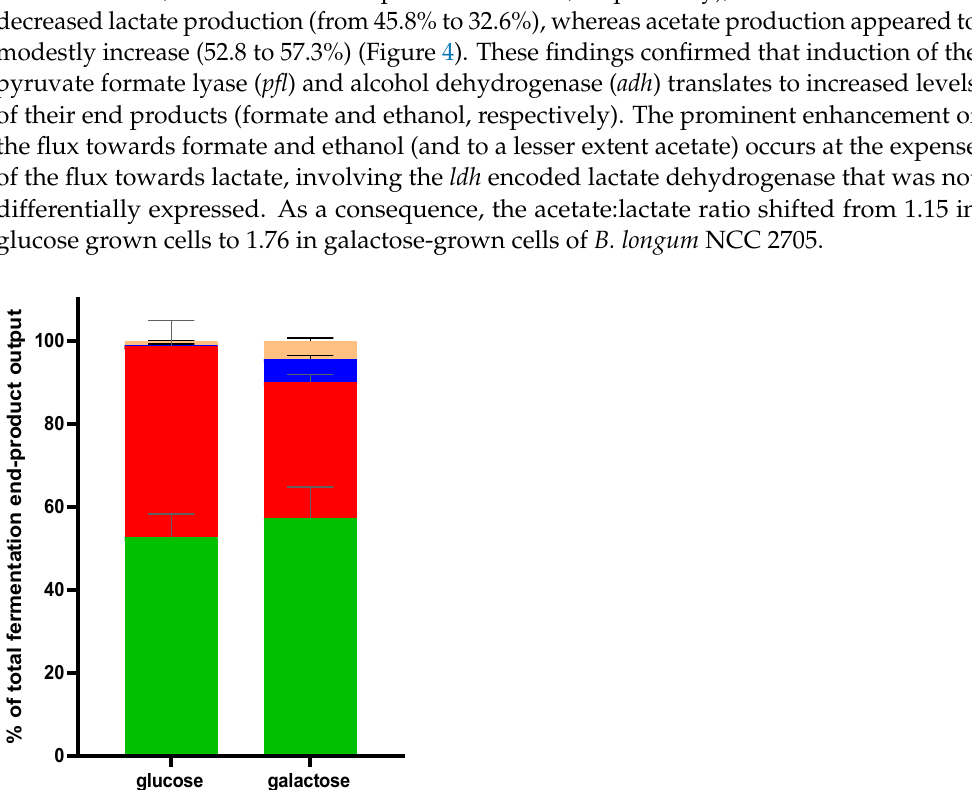
Figure 5. Differential expression of genes related to carbohydrate transport in B. longum NCC 2705 grown on galactose or glucose. Fold expression change in galactose growth induced (green) and glucose growth induced genes (red) are displayed in log2 scale.